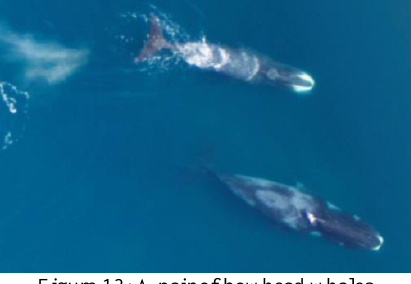
Figure 13: A pair of bowhead whales